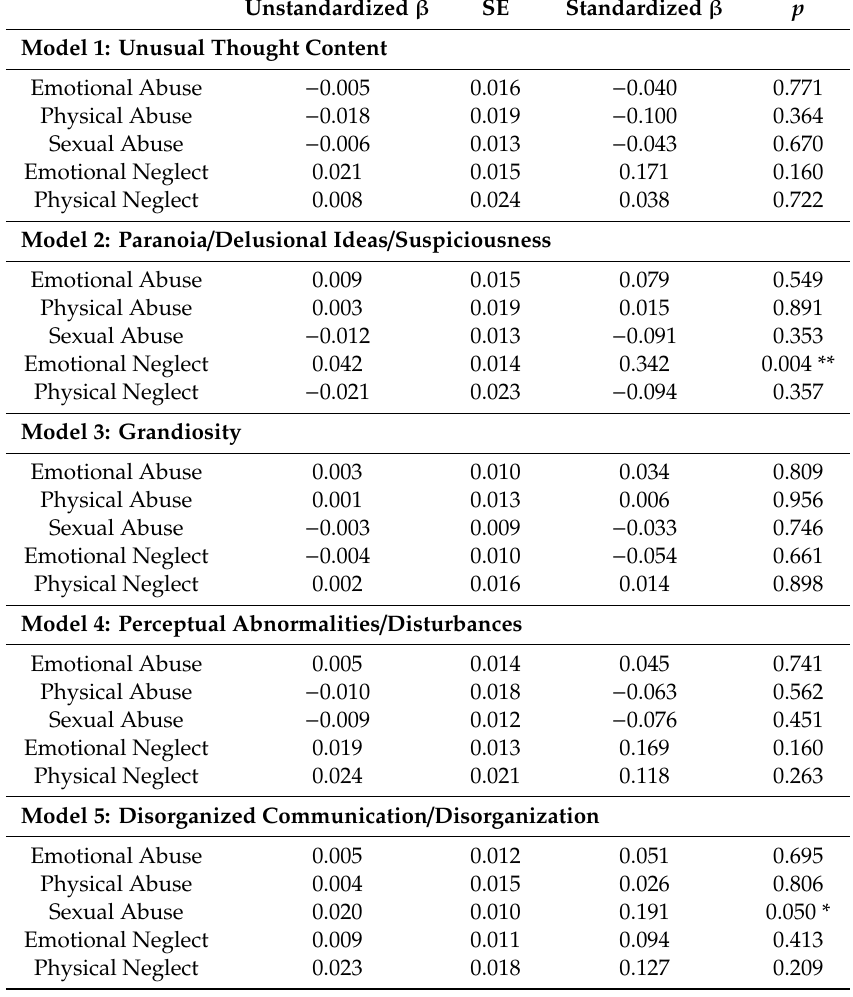
Table 3. Regressions for attenuated positive symptoms and all trauma types ( n = 130). Bonferroni corrected significant p -value =